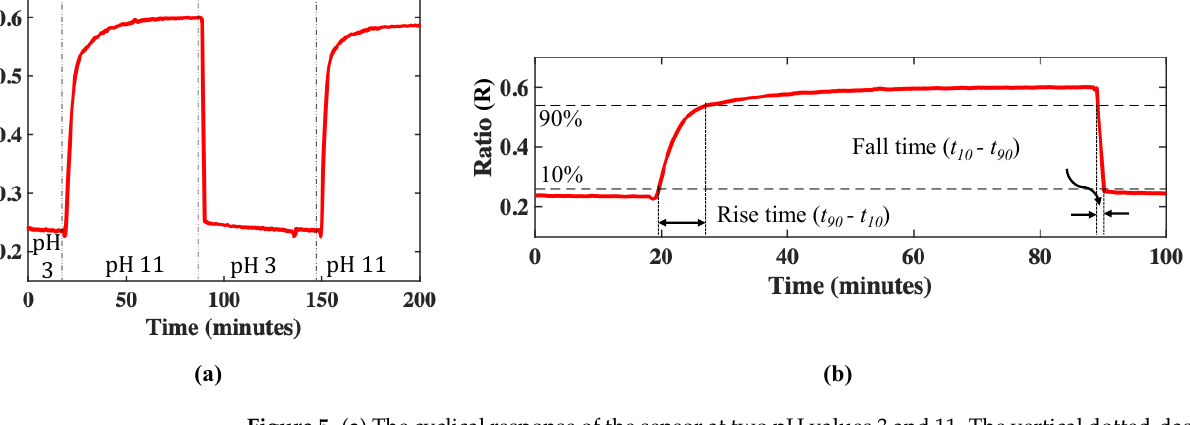
Figure 5. ( a ) The cyclical response of the sensor at two pH values 3 and 11. The vertical dotted-dashed lines show the pH change time. ( b ) The first 100 min of the sensor response shows the rise and fall times, t 10 and t 90 , which, respectively, represent the time taken to reach 10% of the lower and 90% of the higher value of the measured pH.